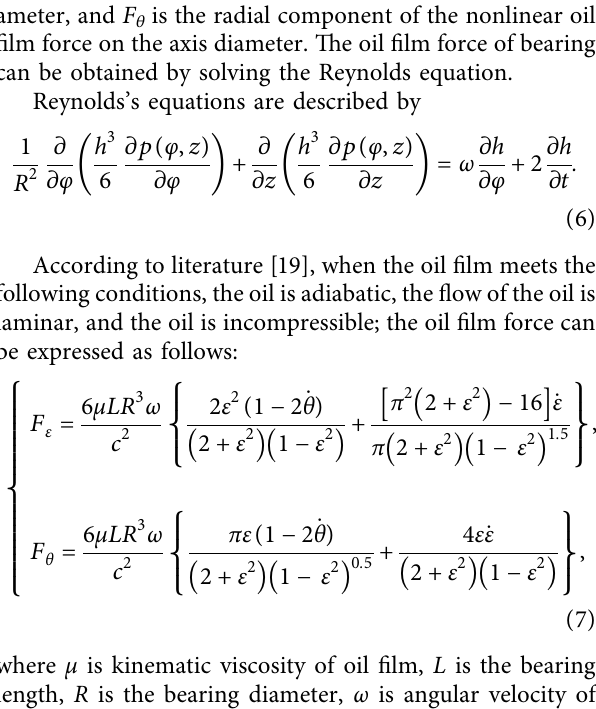
Figure 4: Model of bending stiffness.